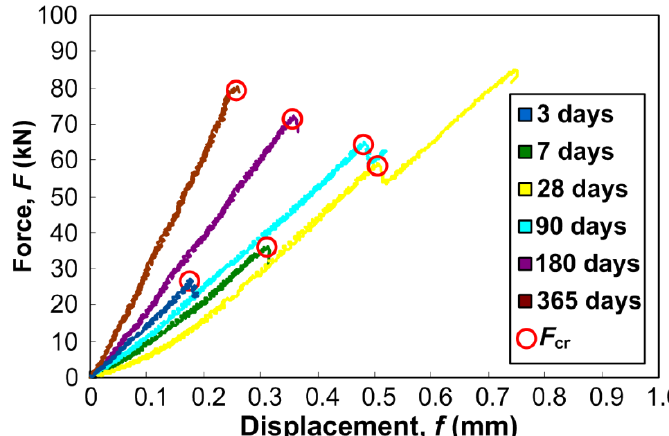
Figure 10. Exemplary force–displacement diagrams for LCFA-20 specimens.